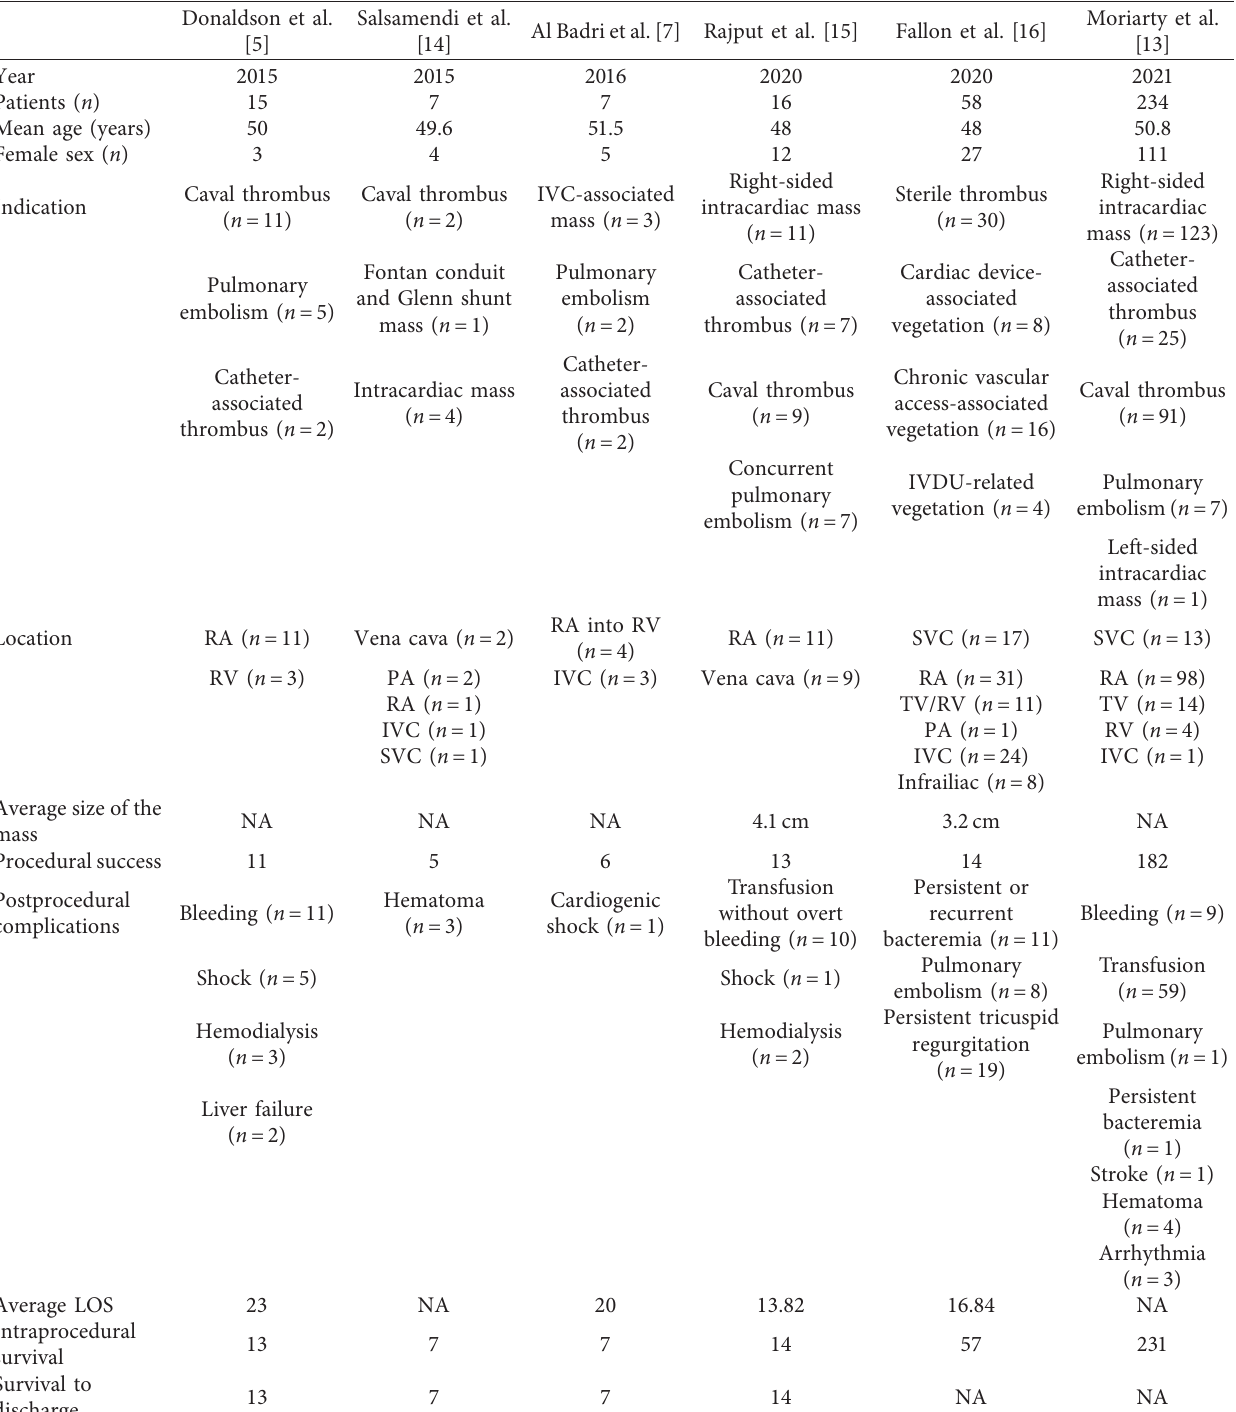
Table 4: Prior retrospective